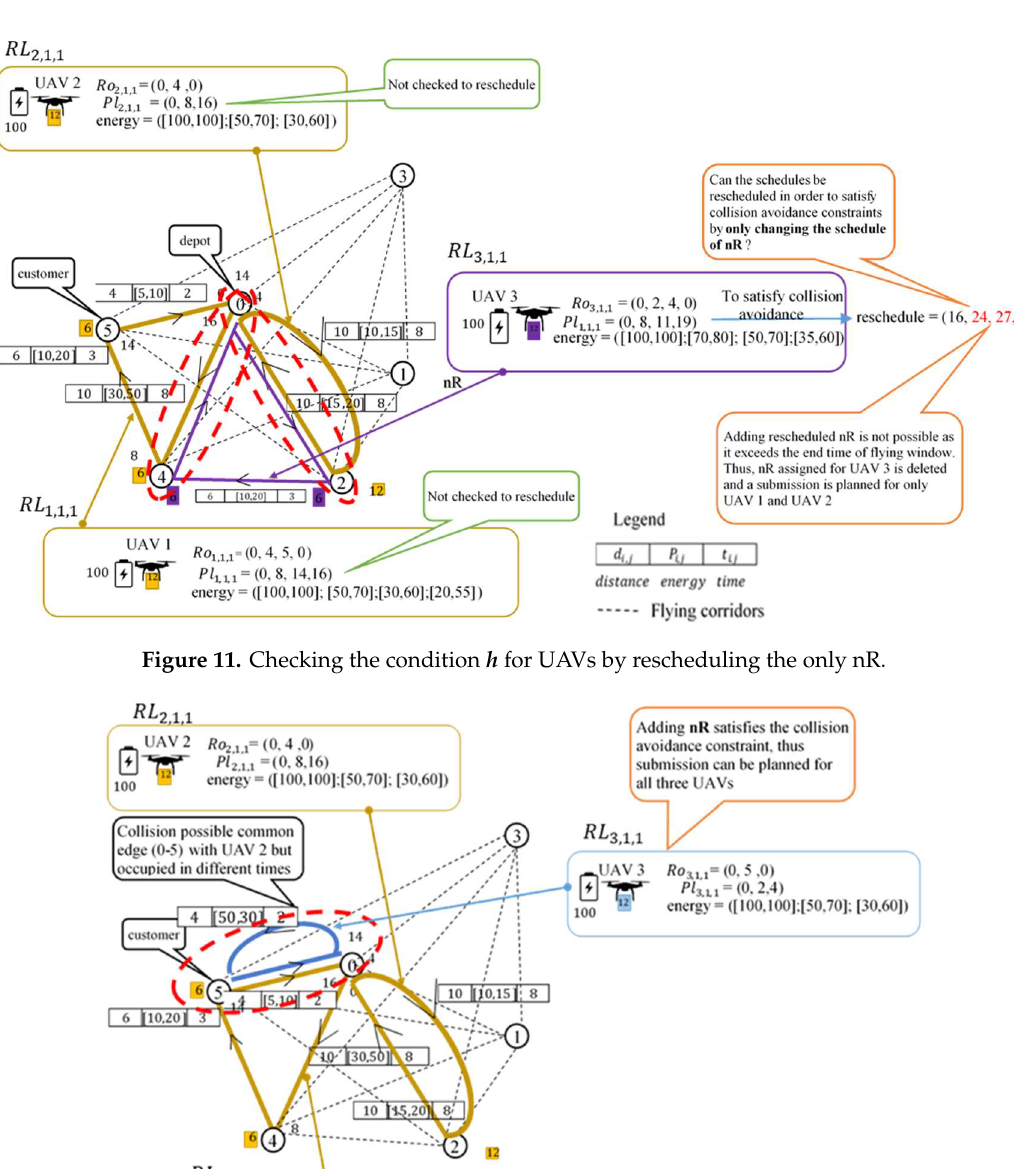
Figure 10. Scenarios assigned to UAVs with collisions, which are not possible to reschedule.